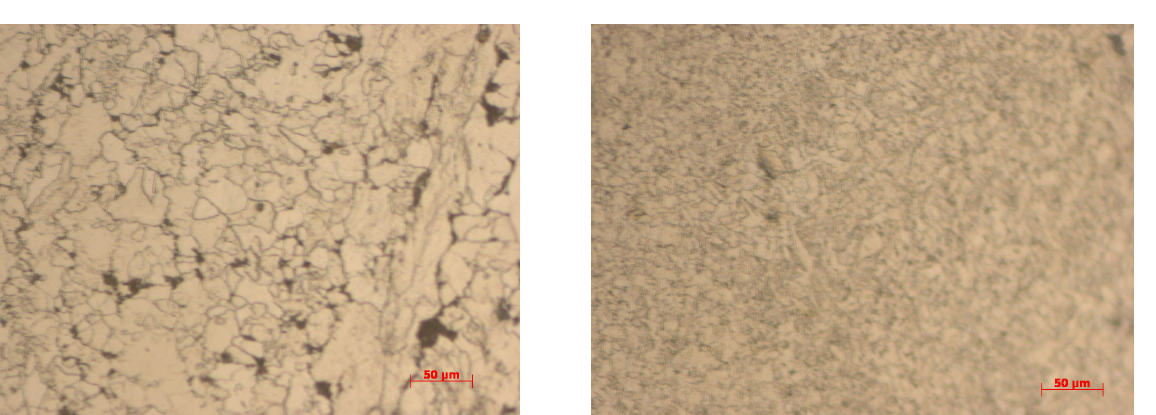
Table 3. Measured Vickers hardness values of the low-carbon microalloyed steels at different cooling rates. The micro- hardness value of as-received steels is about 243 HV.